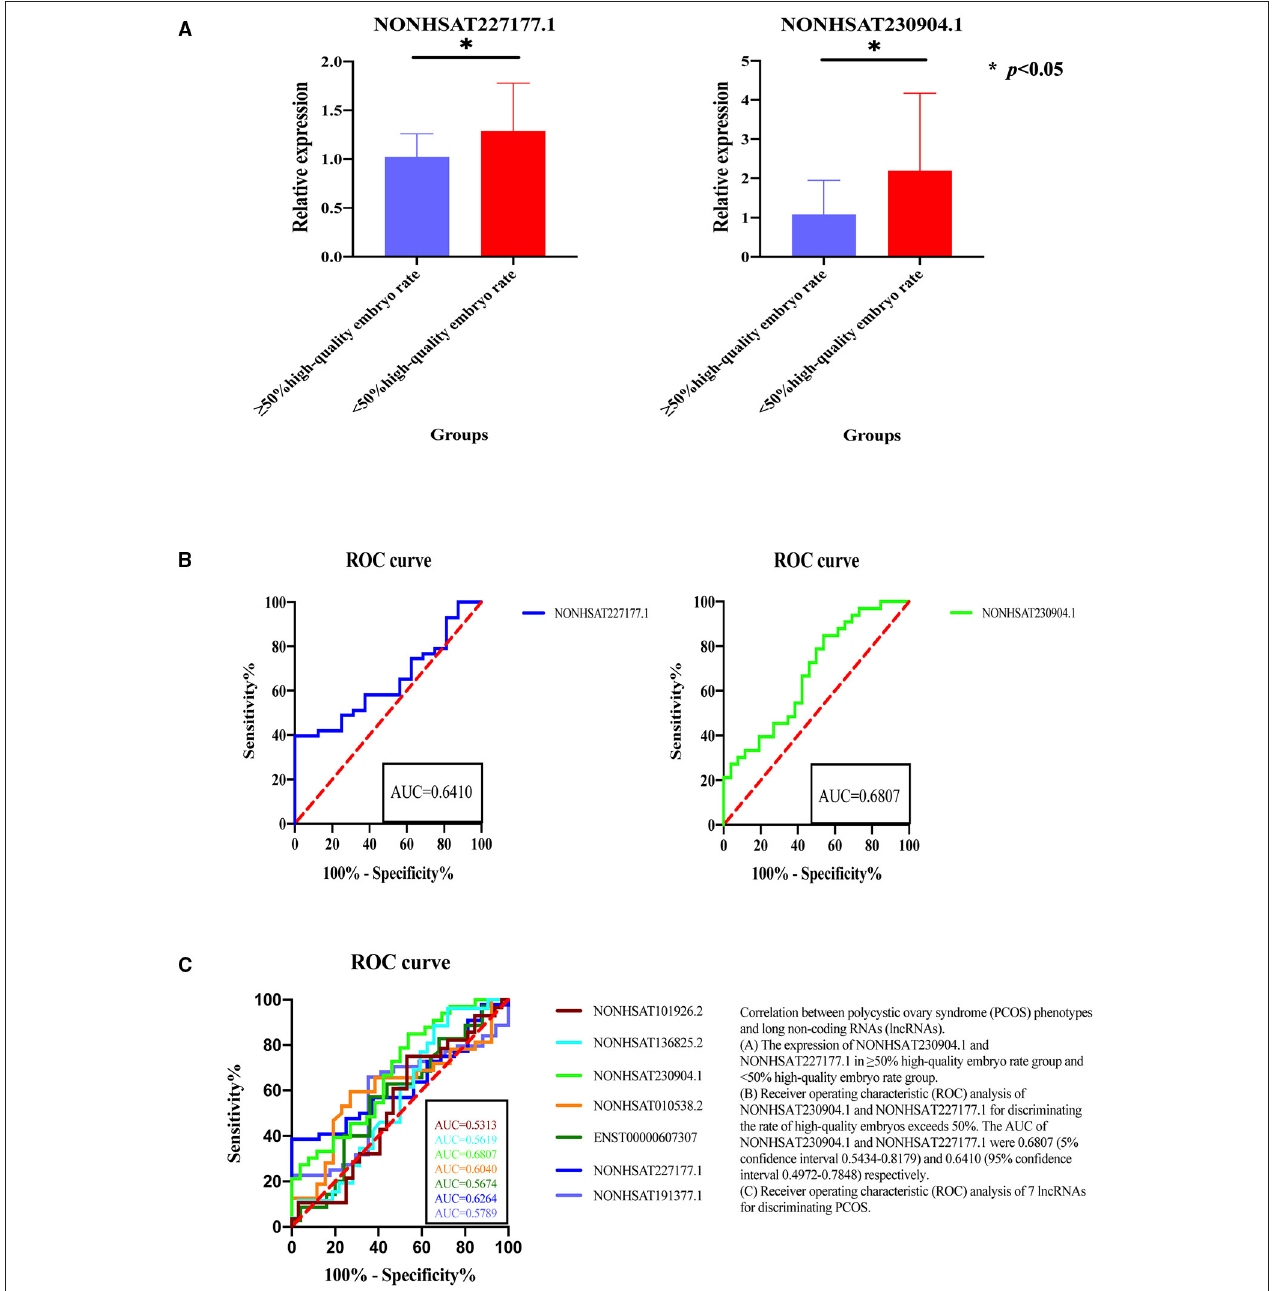
FIGURE 4 | Correlation between polycystic ovary syndrome (PCOS) phenotypes and long non-coding RNAs (lncRNAs). (A) The expression of NONHSAT230904.1 and NONHSAT227177.1 in ≥ 50% high-quality embryo rate group and < 50% high-quality embryo rate group. (B) Receiver operating characteristic (ROC) analysis of NONHSAT230904.1 and NONHSAT227177.1 for discriminating the rate of high-quality embryos exceeds 50%. The AUC of NONHSAT230904.1 and NONHSAT227177.1 were 0.6807 (5% confidence interval 0.5434-0.8179) and 0.6410 (95% confidence interval 0.4972–0.7848) respectively. (C) Receiver operating characteristic (ROC) analysis of 7 lncRNAs for discriminating PCOS. * p <